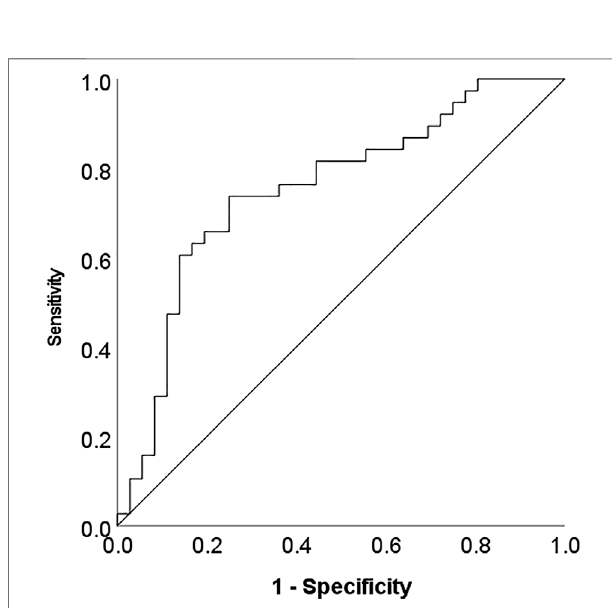
FIGURE 4 | ROC curve analysis indicating the discriminatory power of a subset of metabolites differentiating short and long LTL (below/above mean